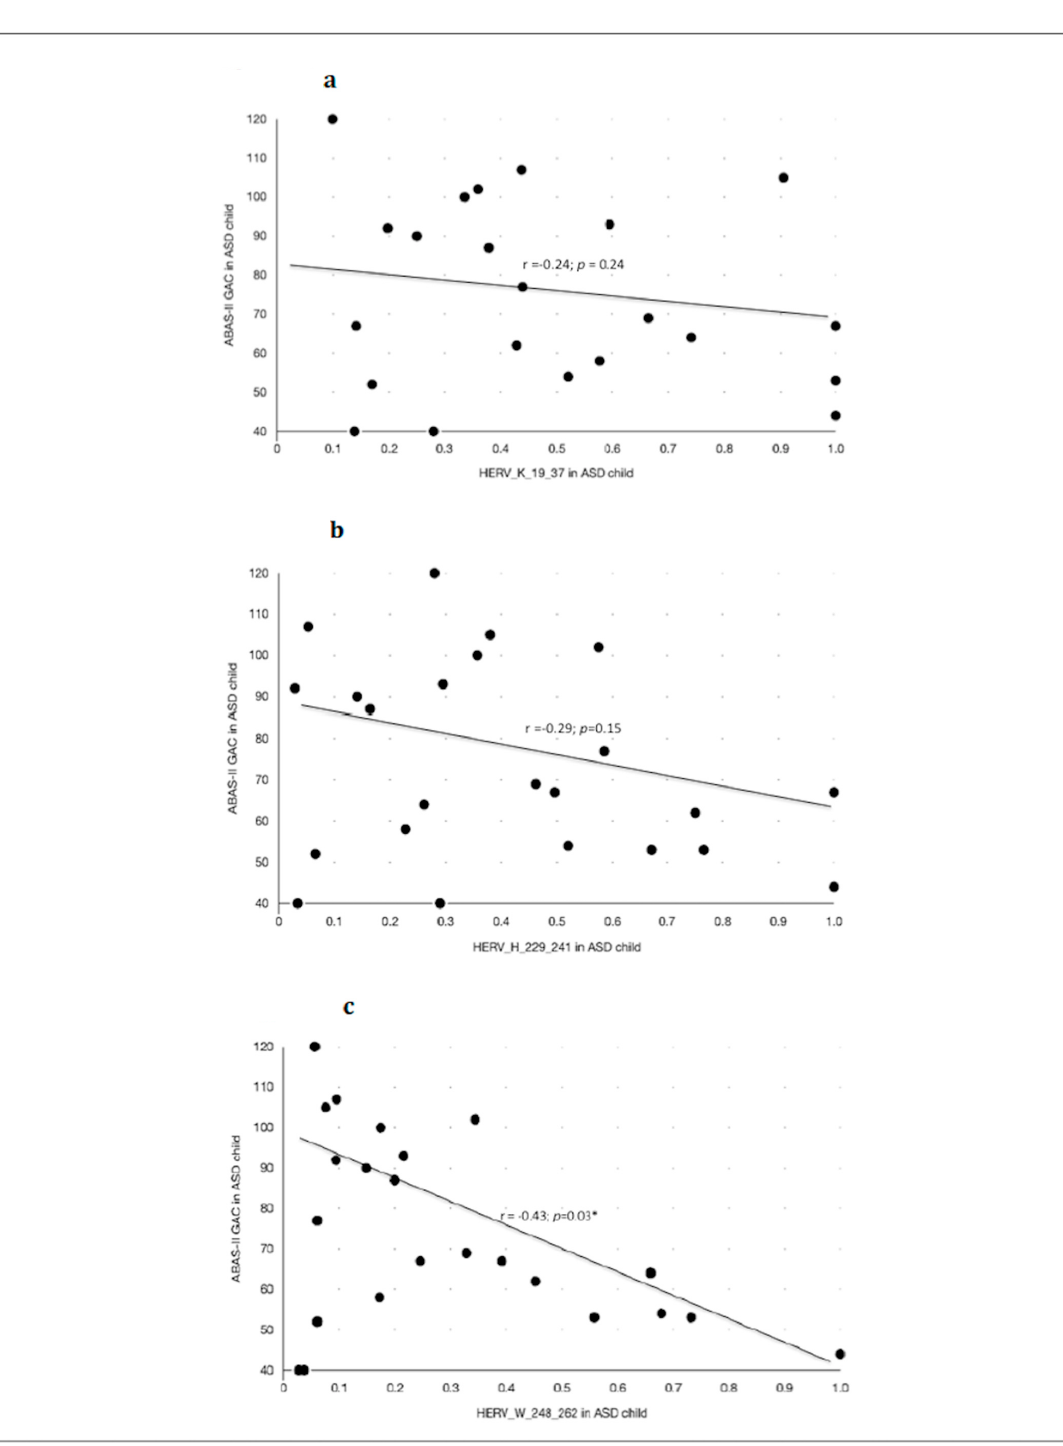
Figure 4. Caption title. Scatter plots of the Pearson’s correlation test between the ABAS-II questionnaire—GAC (Global Adaptative Composite)—Score and the anti-HERVs levels in children with ASD. ( a ) Association between anti-HERV-K and the Global Adaptive Composite Score of the ABAS-II questionnaire in children with ASD diagnosis. ( b ) Association between anti-HERV-H and the Global Adaptive Composite Score of the ABAS-II questionnaire in children with ASD diagnosis. ( c ) Association between anti-HERV-W and the Global Adaptive Composite Score of the ABAS-II questionnaire in children with ASD diagnosis. Statistical significant levels fixed at * p <